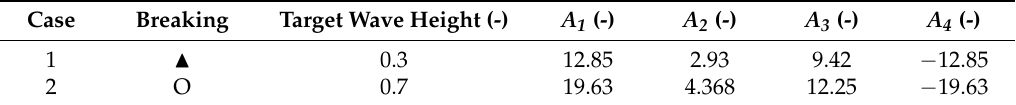
Table 2. Parameters for generating solitary waves.